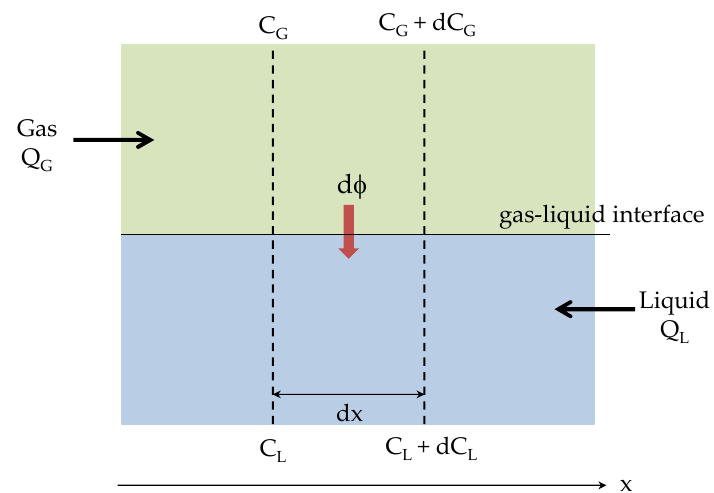
Figure 1. Nomenclature for the material balances in a countercurrent gas–liquid absorber.